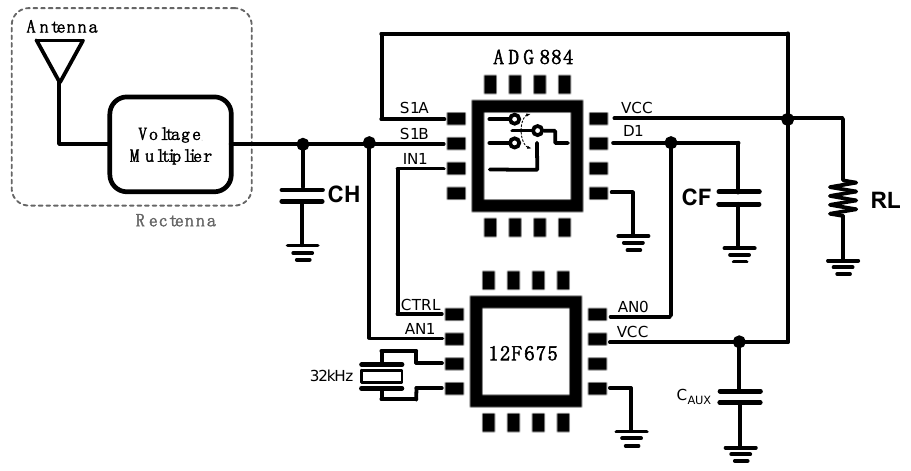
Figure 11. Proposed system block diagram.